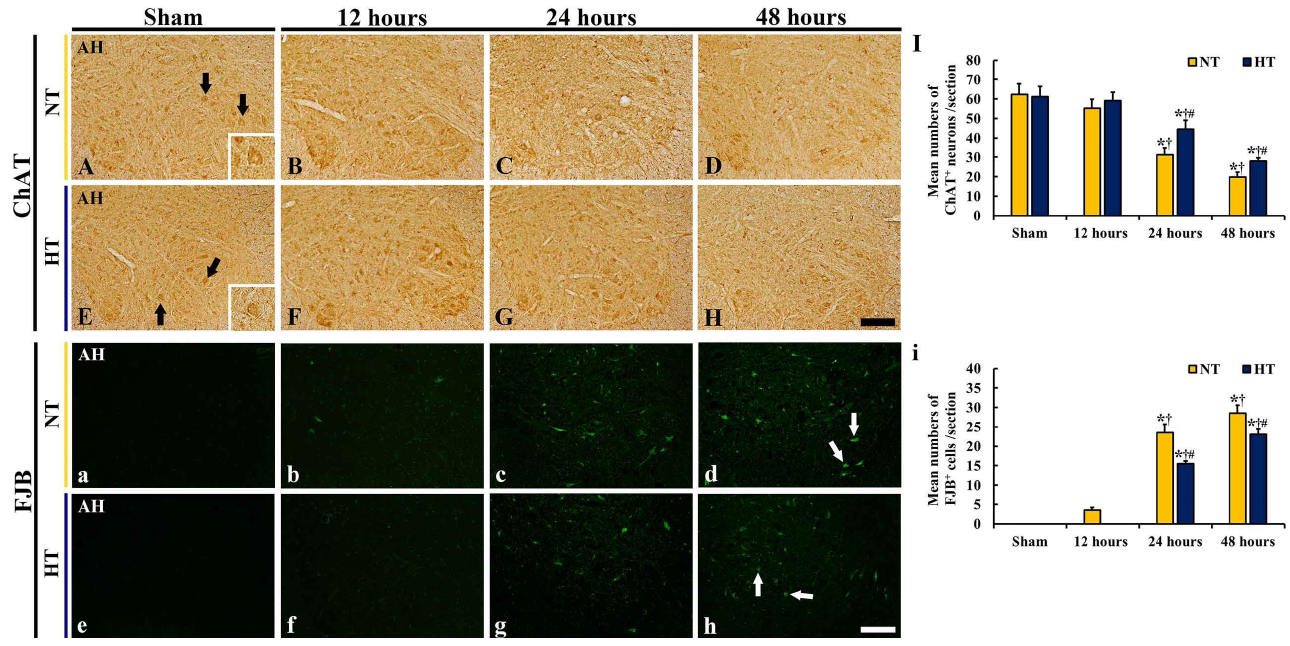
Figure 3. ( A – H and a – h ) ChAT immunohistochemistry (A-H) and FJB fluorescence ( a – h ) in the anterior horn of the sham-NT ( A , a ), sham-HT ( E , e ), CA-NT ( B – D , b – d ), and CA-HT ( F – H , f – h ) groups at 12 ( B , F , b , f ), 24 ( C , G , c , g ), and 48 ( D , H , d , h ) hours after CA/ROSC. In both CA-NT and CA-HT groups, ChAT + motor neurons (black arrows) are significantly reduced at 24 and 48 h after CA/ROSC; however, the numbers found in the CA-HT group are significantly higher than those in the CA-NT group. The numbers of FJB + motor neurons (white arrows) are significantly increased in the CA-NT group at 24 and 48 h after CA/ROSC, but, in the CA-HT group, FJB + motor neurons are significantly low in number compared with the CA-NT group. AH, anterior horn. Scale bar = 200 µm. ( I and i ) Mean numbers of ChAT + ( I ) and FJB + ( i ) motor neurons in the anterior horn. The bars indicate the means ± SD ( n = 6, respectively; * p < 0.05 vs. each sham group; † p < 0.05 vs. previous time-point group; # p < 0.05 vs. corresponding CA-NT group).